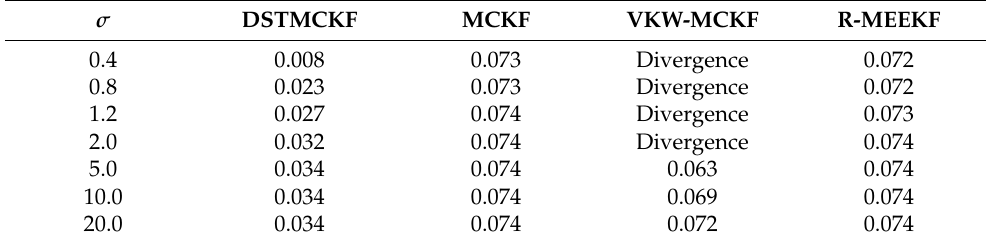
Table 4. RMSE (m) with different σ (Case 3).